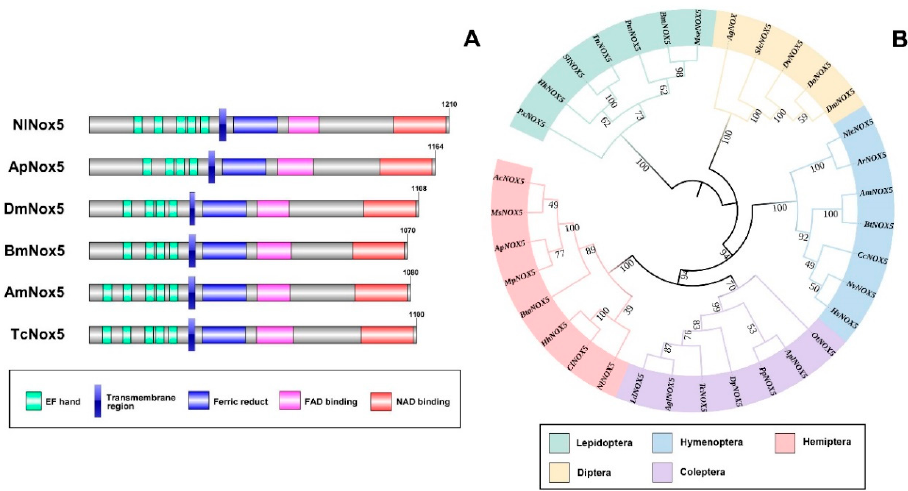
Figure 1. The predicted protein sequence analysis of NADPH oxidase 5 (Nox5) of insects. ( A ) Domain organizations of the deduced Nox5 proteins of several insect species. The conserved domains / motifs were predicted by SMART (http: // smart.embl.de / ). The green boxes indicate the calcium-binding EF-hand motifs; blue boxes refer to the ferric reductase transmembrane components; pink and red boxes refer to the binding domains for flavine adenine dinucleotide (FAD) and nicotinamide adenine dinucleotide (NAD). Amino acids are numbered on the right of each Nox5 protein. ( B ) Phylogenetic relationship between Nilaparvata lugens Nox5 and the orthologs of other insect species. The phylogenetic tree was constructed by Maximum likelihood program Mega X (http: // www.megasoftware.net / )